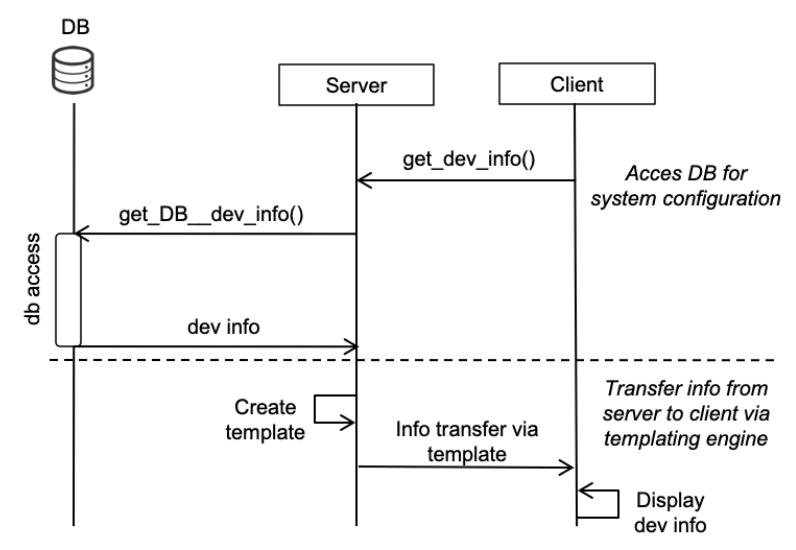
Figure 3. Interaction